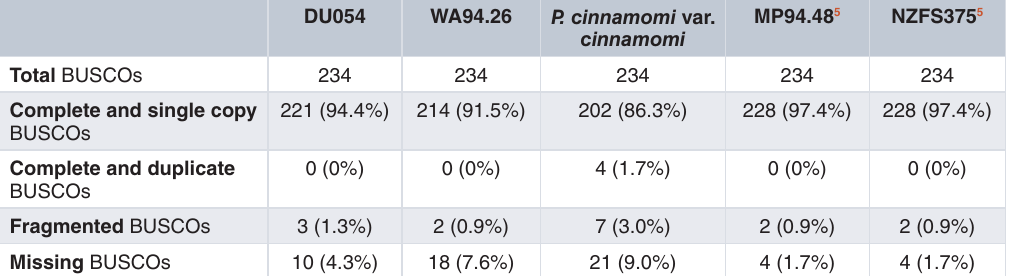
Table 2. Summary of BUSCO assessment.